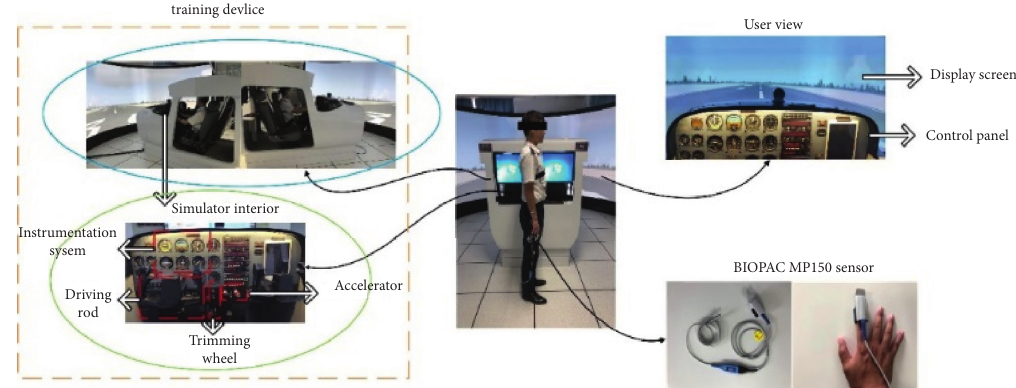
Figure 3: Simulator flight experiment